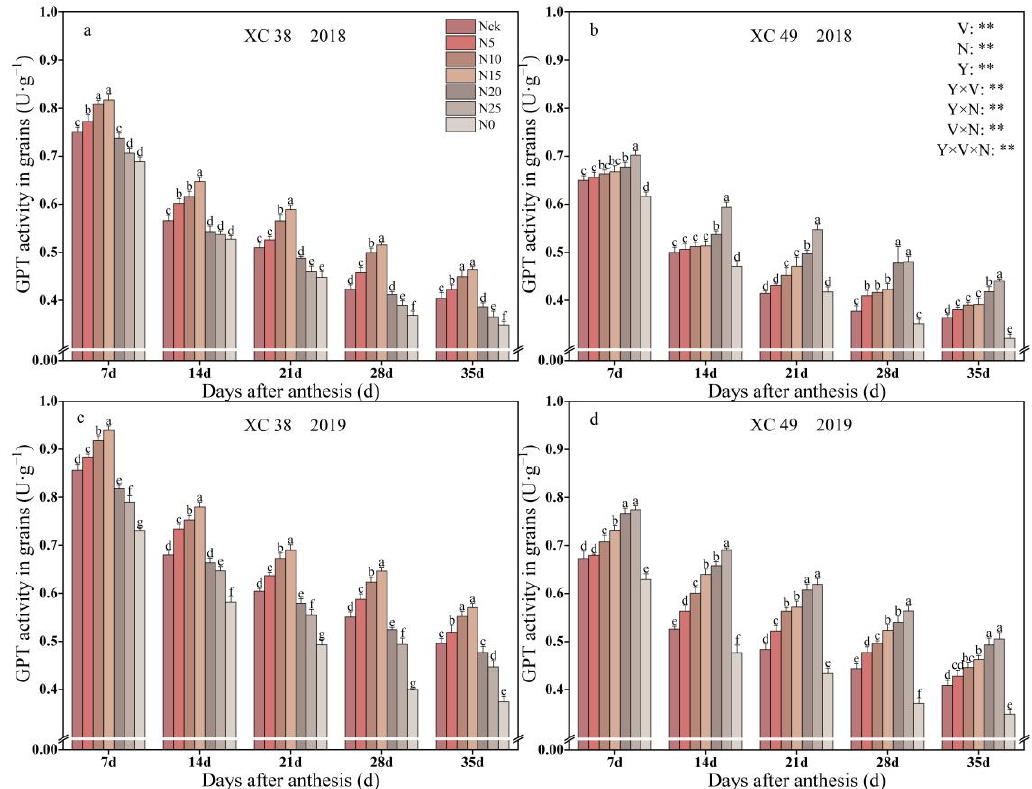
Figure 4. Effects of different nitrogen treatments on GPT activity in grain in 2018 and 2019. ( a ) GPT activity of XC 38 grains in 2018; ( b ) GPT activity of XC 49 grains in 2018; ( c ) GPT activity of XC 38 grains in 2019; ( d ) GPT activity of XC 49 grains in 2019. XC 38: Xinchun 38; XC 49: Xinchun 49; Nck: 300 kg hm −2 , N5: 285 kg hm −2 , N10: 270 kg hm −2 , N15: 255 kg hm −2 , N20: 240 kg hm −2 , N25: 225 kg hm −2 , N0: 0 kg hm −2 ; V: Variety, N: Nitrogen, Y: Year. ** represents significant differences at 0.01 level. Different lowercase letters in the figure represent significant differences at 0.05 level.